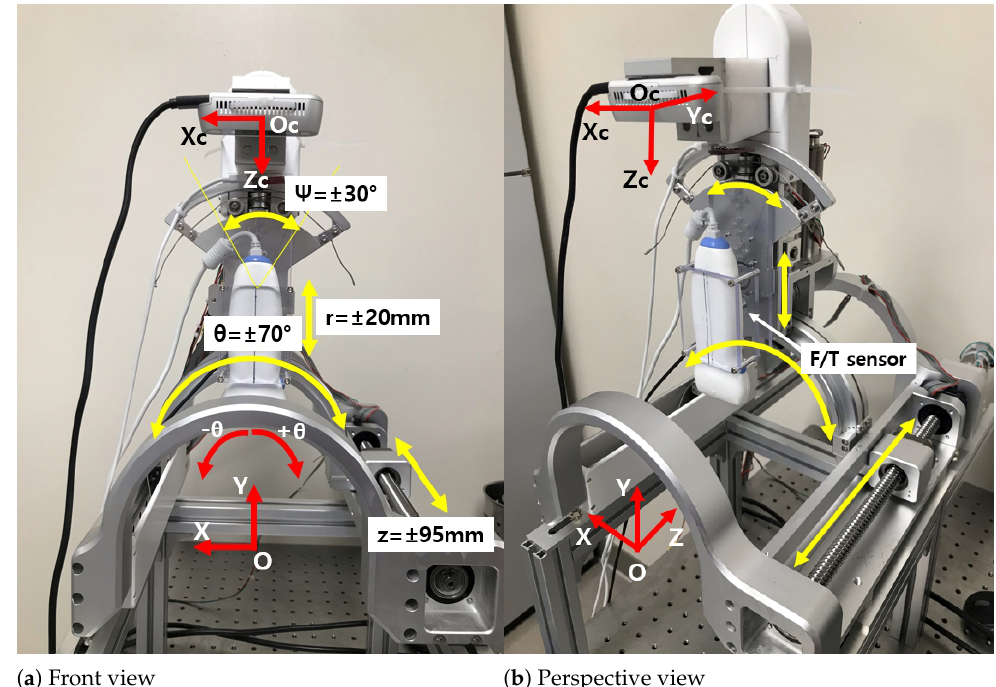
Figure 1. Overview of the modified 4-DOF sarcopenia detection